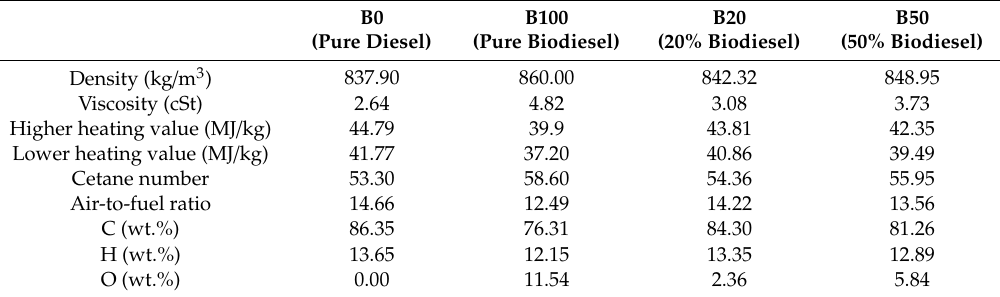
Table 6. Combustion characteristics of diesel blends [45].